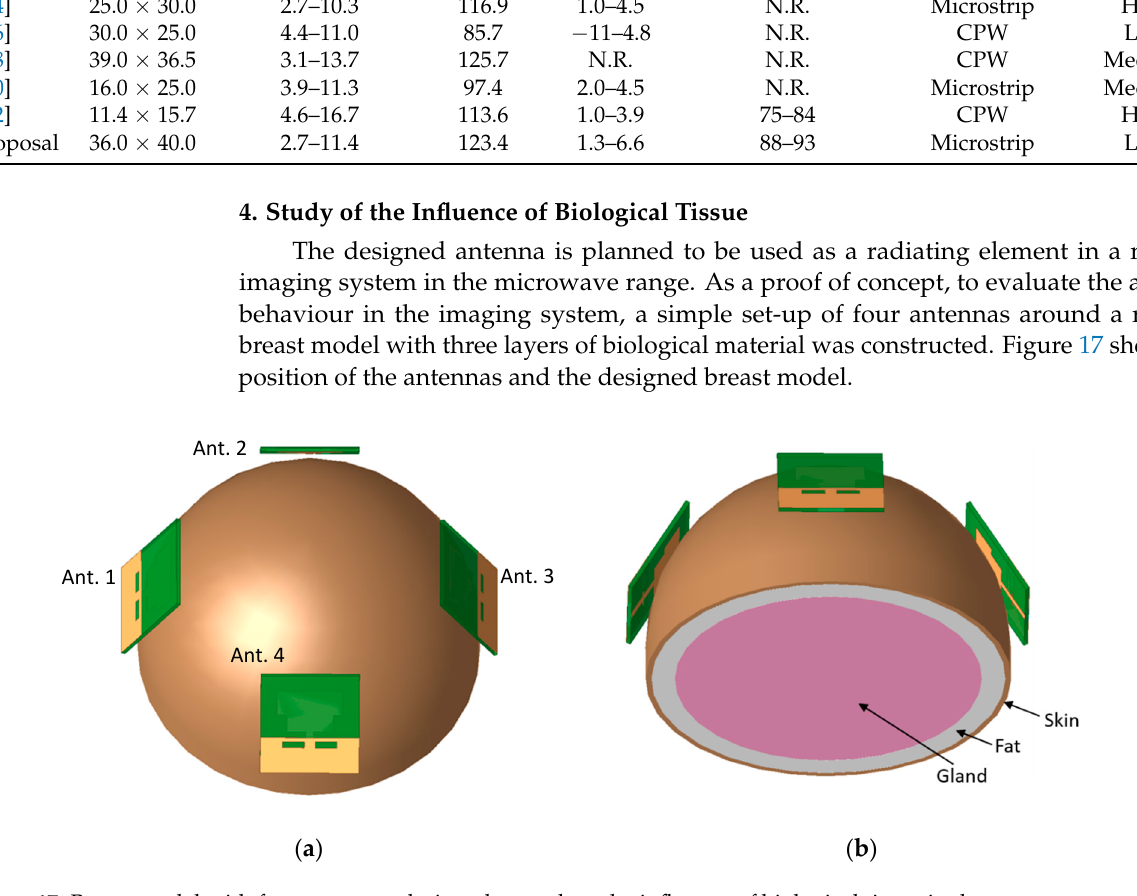
Table 4. Dielectric Properties of the Breast Model. Material